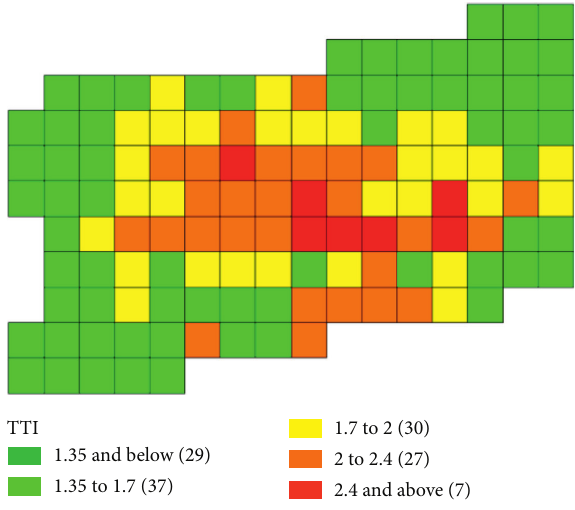
Figure 7: Traffic index.